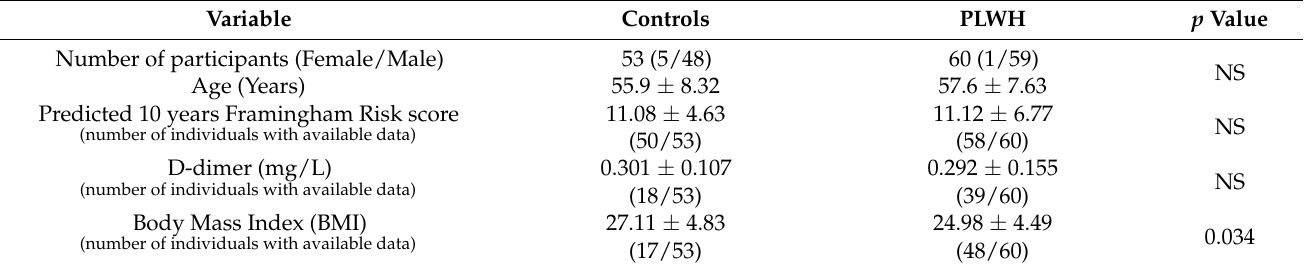
Table 1. Demographic and clinical parameters of study participants. Numbers are shown in Mean ± SD. N/A: non-applicable. NA: